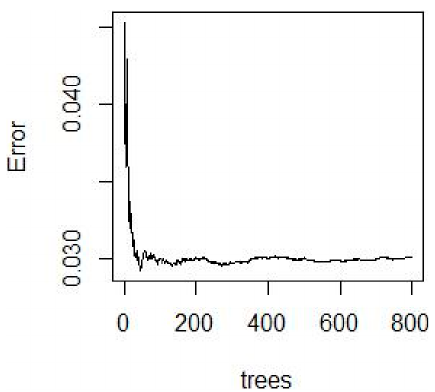
Figure 12. Nitrogen content error rate varies with tree number.